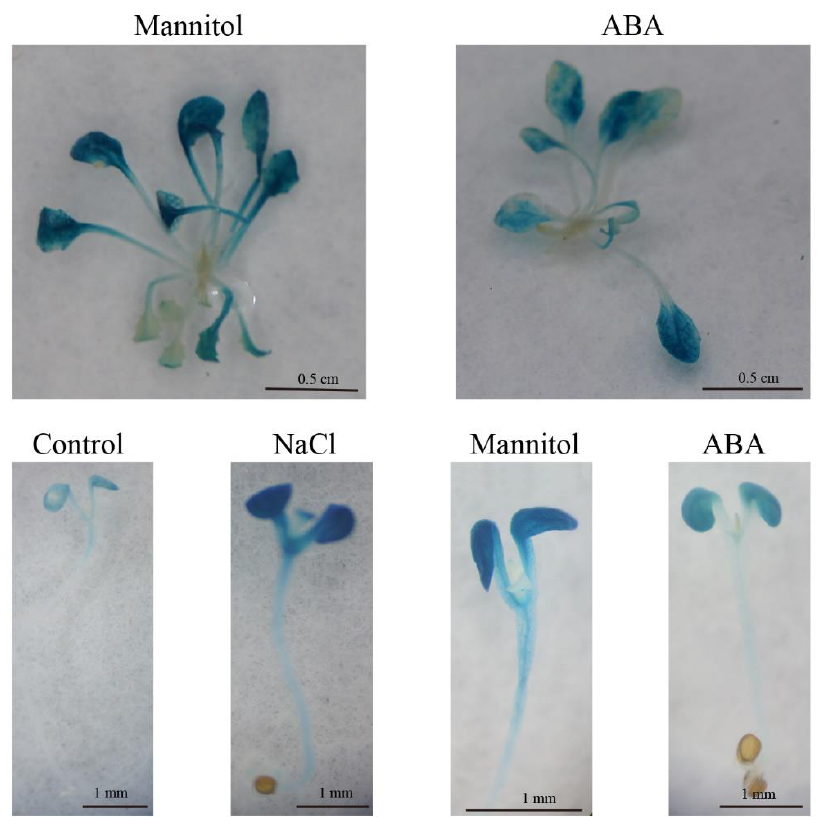
Figure 9. Histochemical GUS staining of FvTLP 1pro::GUS transgenic Arabidopsis . Three-week-old seedlings growing on half-strength MS medium were transferred to half-strength MS medium without or with 150 mM NaCl, 200 mM mannitol, or 100 μM ABA. Seeds of FvTLP 1pro::GUS transgenic Arabidopsis were surface-sterilized and germinated on half-strength MS medium supplemented without or with 75 mM NaCl, 75 mM mannitol, or 0.25 μM ABA.